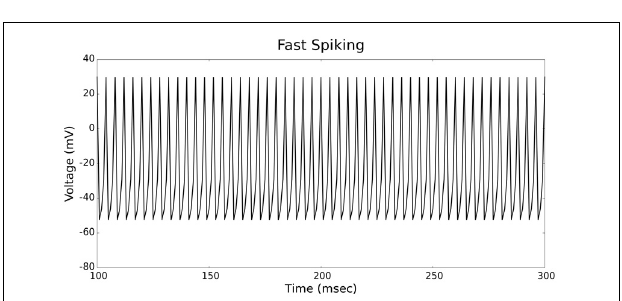
FIGURE 6 | LIF neuron model: fast spiking firing patterns.